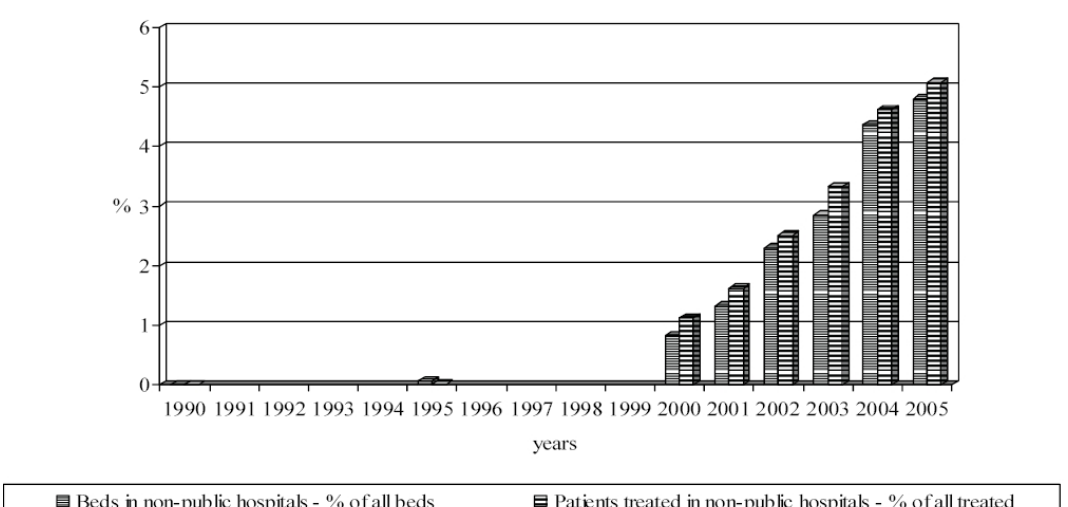
Fig. 4 Effects of the general hospitals’